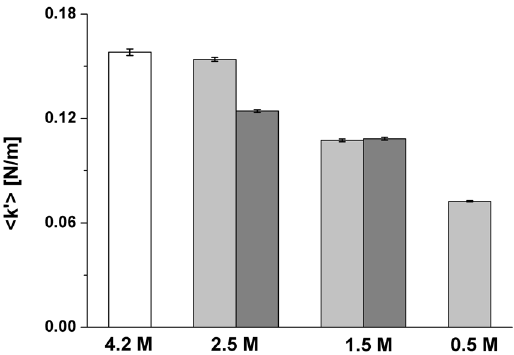
Figure 6. Mean effective force constant < k’ > of Hbt. salinarum , for different conditions. Columns represent values for a given salinity and incubation time (1 hour, light grey or 24 hours, dark grey). The white column is the control sample at physiological salt molarity. Errors bars represent standard